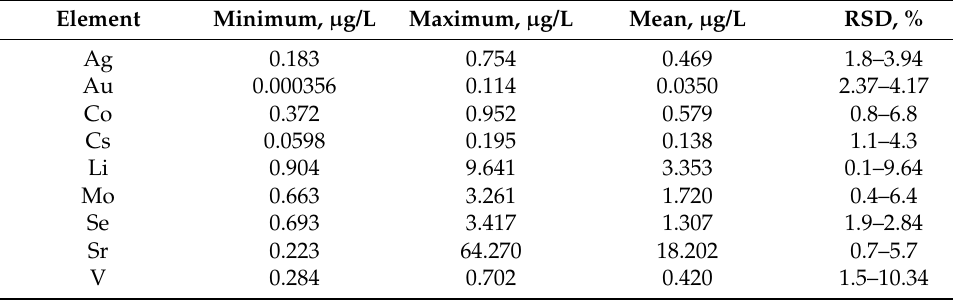
Figure 8. The plot as a violin with the box for the V level ( µ g/L) in the examined products (A–Q).